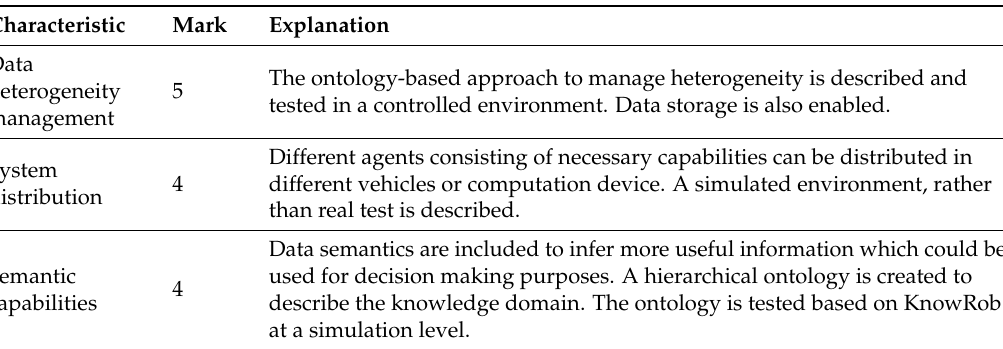
Table 15. Pandora Table 15. Pandora assessment.